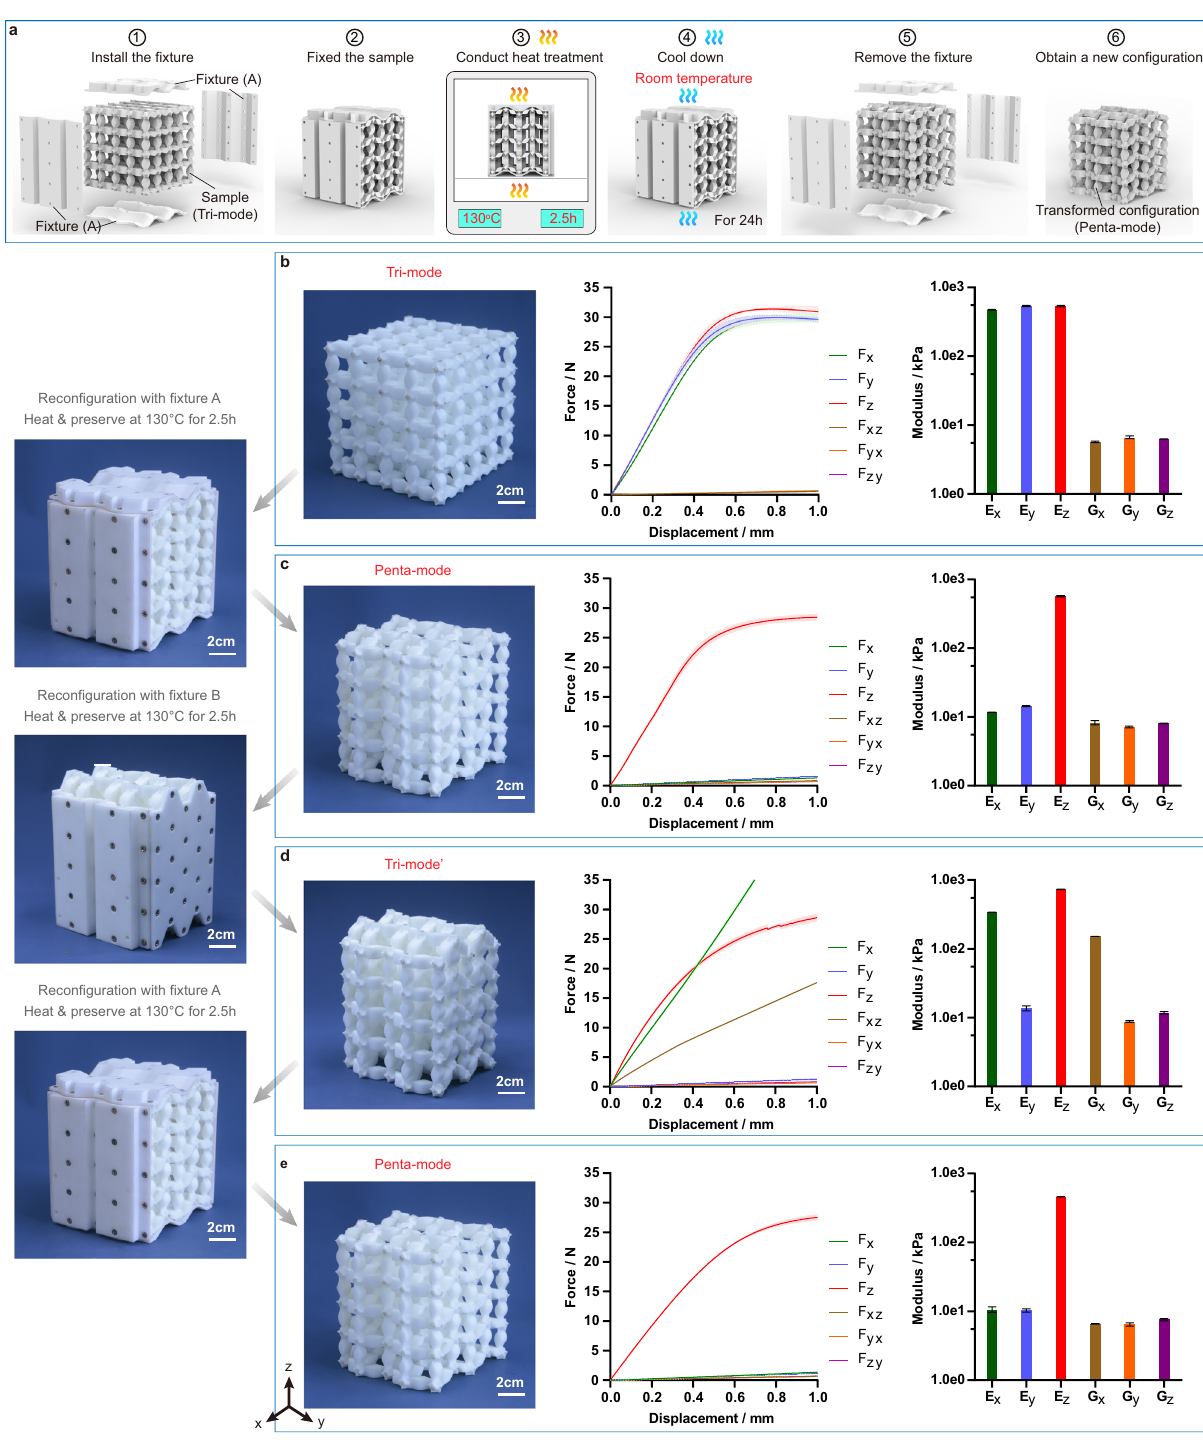
Fig.2|Therecon fi gurationandexperimentalvalidationofa3Dtransformablemetamaterial.a Theschematicshowingtransformationstepswiththe fi xtureandheat treatmentintermediatesteps. b The3Dprintedtri-modemetamaterialanditsexperimentaldisplacement-forcecurvesandcalculatedelasticmoduli.Lines:mean;shading: one standard deviation. c The recon fi gured penta-mode metamaterial and its experimental displacement-force curves and calculated elastic moduli. d The recon fi gured alternativetri-mode(tri-mode ’ )metamaterialanditsexperimentaldisplacement-forcecurvesandcalculatedelasticmoduli. e Thepenta-modemetamaterialrecon fi gured back from tri-mode ’ con fi guration and its experimental displacement-force curves and calculated elastic moduli. Error bars represent standard